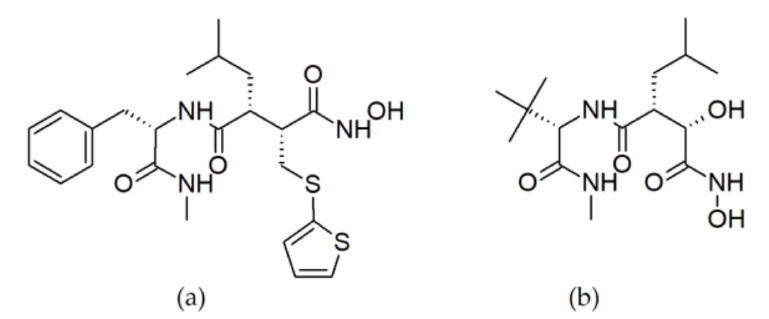
Figure 3. Chemical structures of: ( a ) batimastat; ( b )